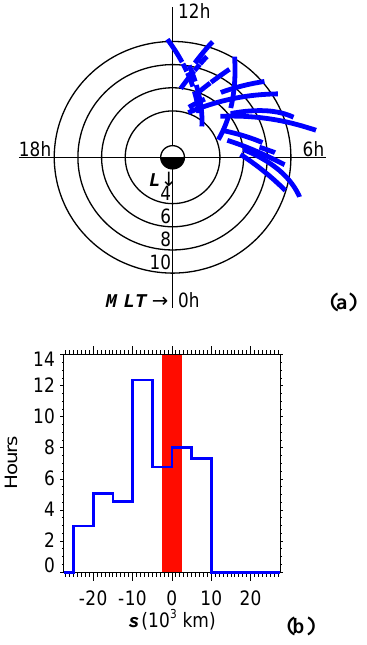
Fig. 2. Orbits of the TC-1 spacecraft during the selected chorus events. (a) Polar plot represents portions of orbits (thick blue lines) as a function of McIlwain’s L parameter and the magnetic local time (MLT). (b) Histogram shows number of hours spent by the spacecraft during the selected chorus events at different distances from the geomagnetic equator. The distances are calculated as arc lengths along the magnetic field lines; negative values of s are used for observations at negative geomagnetic latitudes. The histogram bin size is 5000km. Red rectangle represents expected position of the chorus source